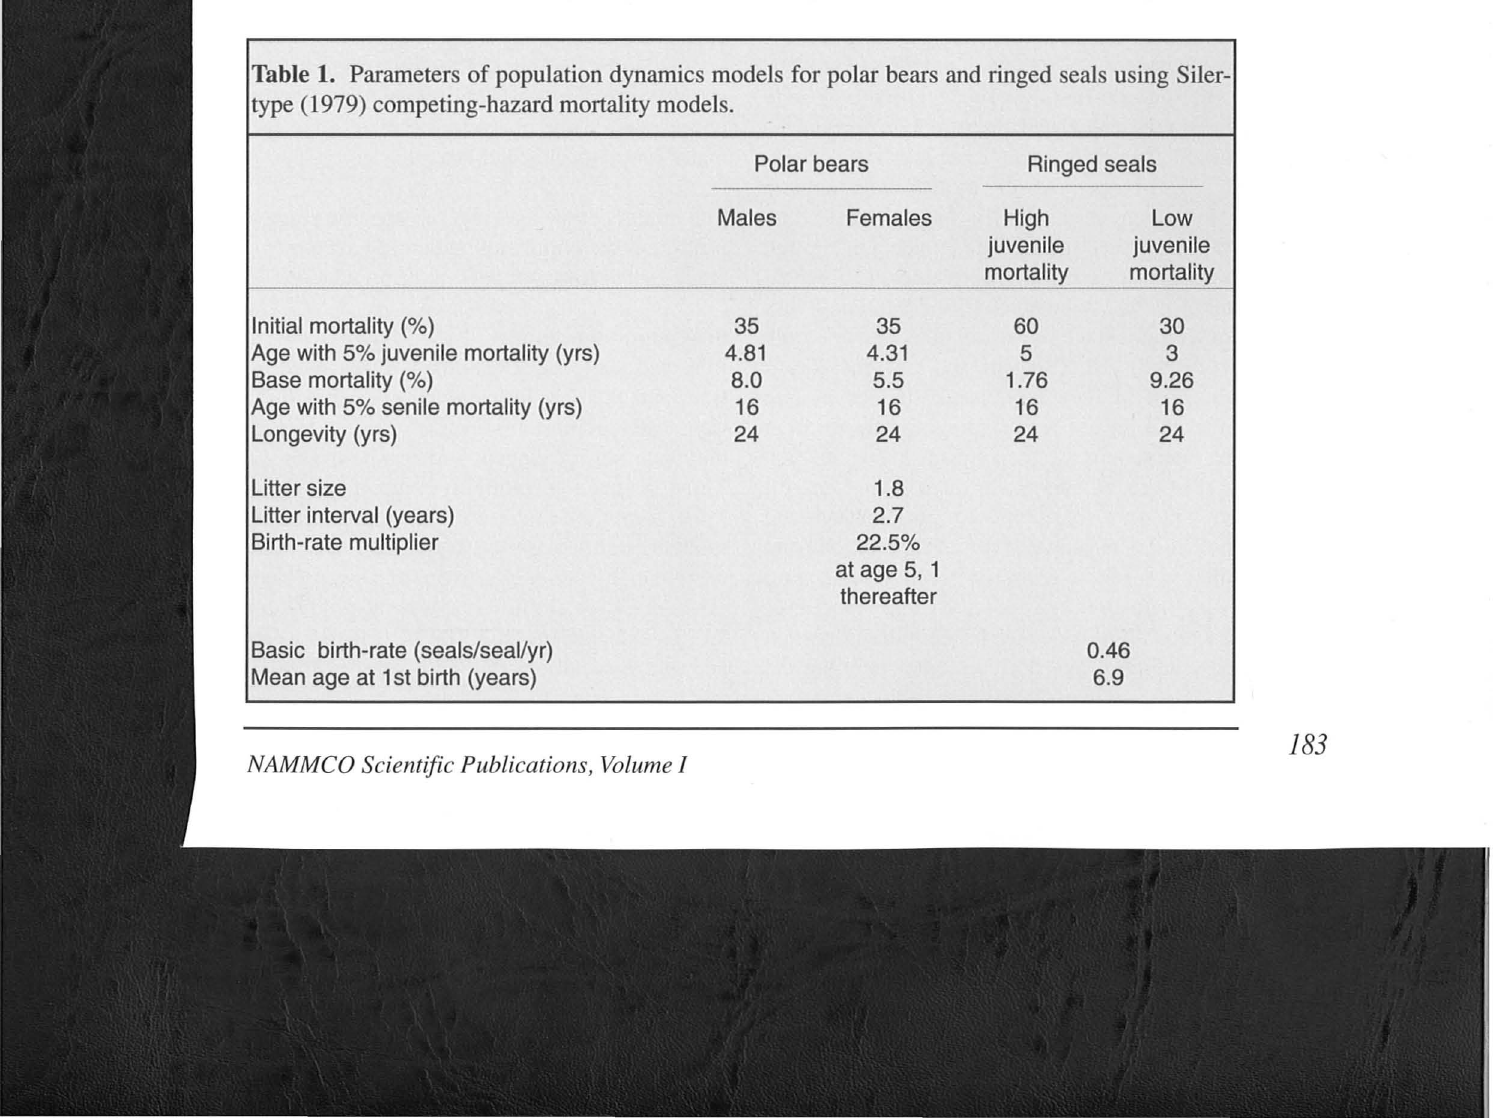
Table 1. Parameters of population dynamics models for polar bears and ringed seals using Siler- type (1979) competing-hazard mortality